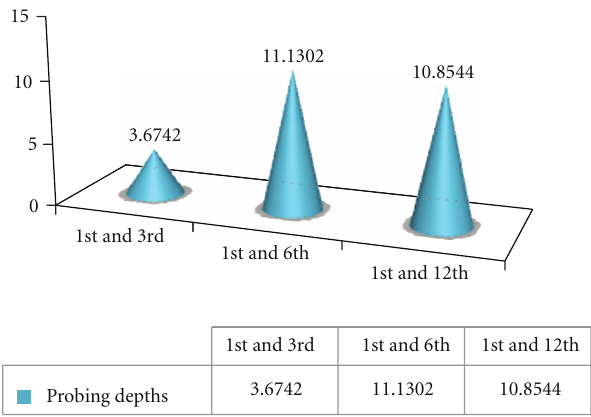
Figure 8: Graphical representation of tabulated probing depth values of Control Group A.